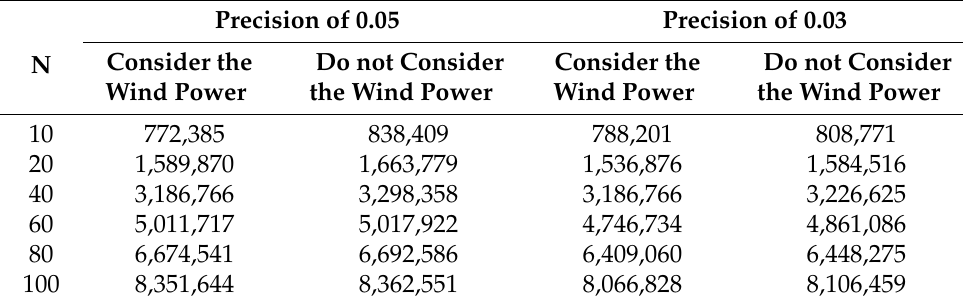
Table 2. The total operating cost of the system in two cases.